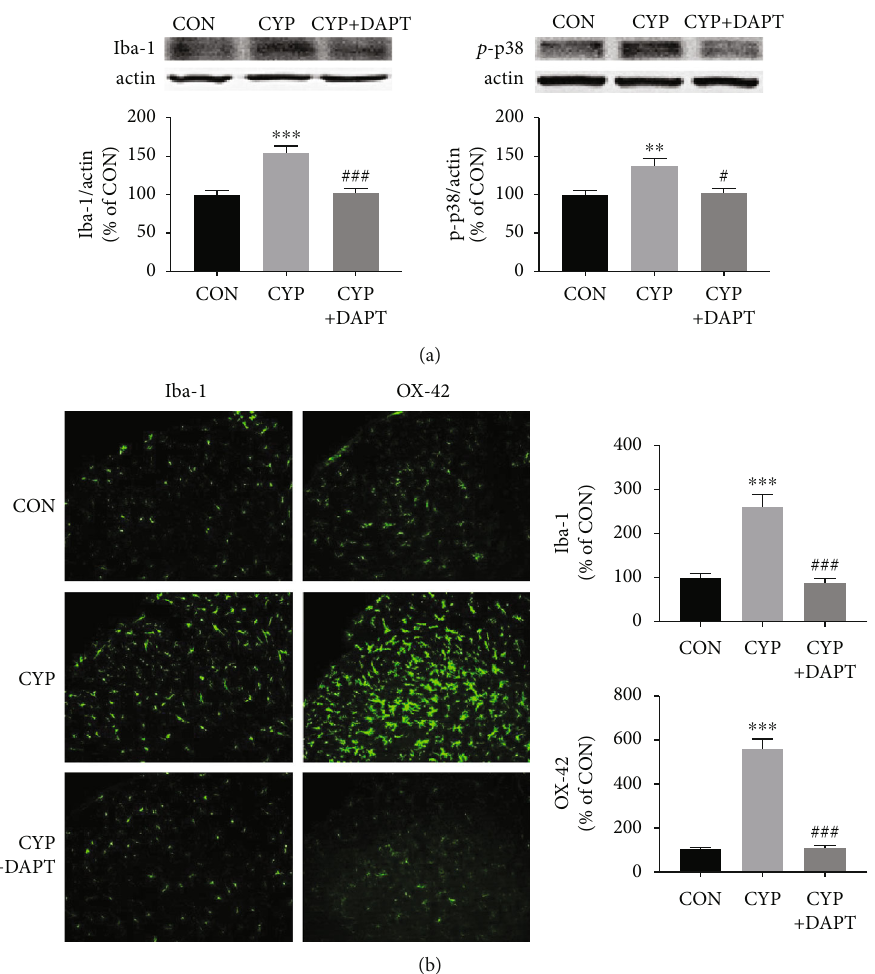
Figure 3: Inhibition of Notch1 signaling suppressed microglia activation in the SDH of the CYP-induced cystitis model. (a) Western blotting analysis showed that intrathecal injection of DAPT signi fi cantly neutralized the overexpression of Iba-1 and p -p38, which are markers of microglia activation. (b) Immuno fl uorescence staining also showed that intrathecal injection of DAPT signi fi cantly neutralized the overexpression of microglia activation markers, Iba-1 and OX-42. n = 5 per group. ∗∗ P < 0 : 01 and ∗∗∗ P < 0 : 001 vs. CON group; # P < 0 : 05 and ### P < 0 : 001 vs. CYP group. Data were analyzed by one-way ANOVA followed by the Tukey post hoc